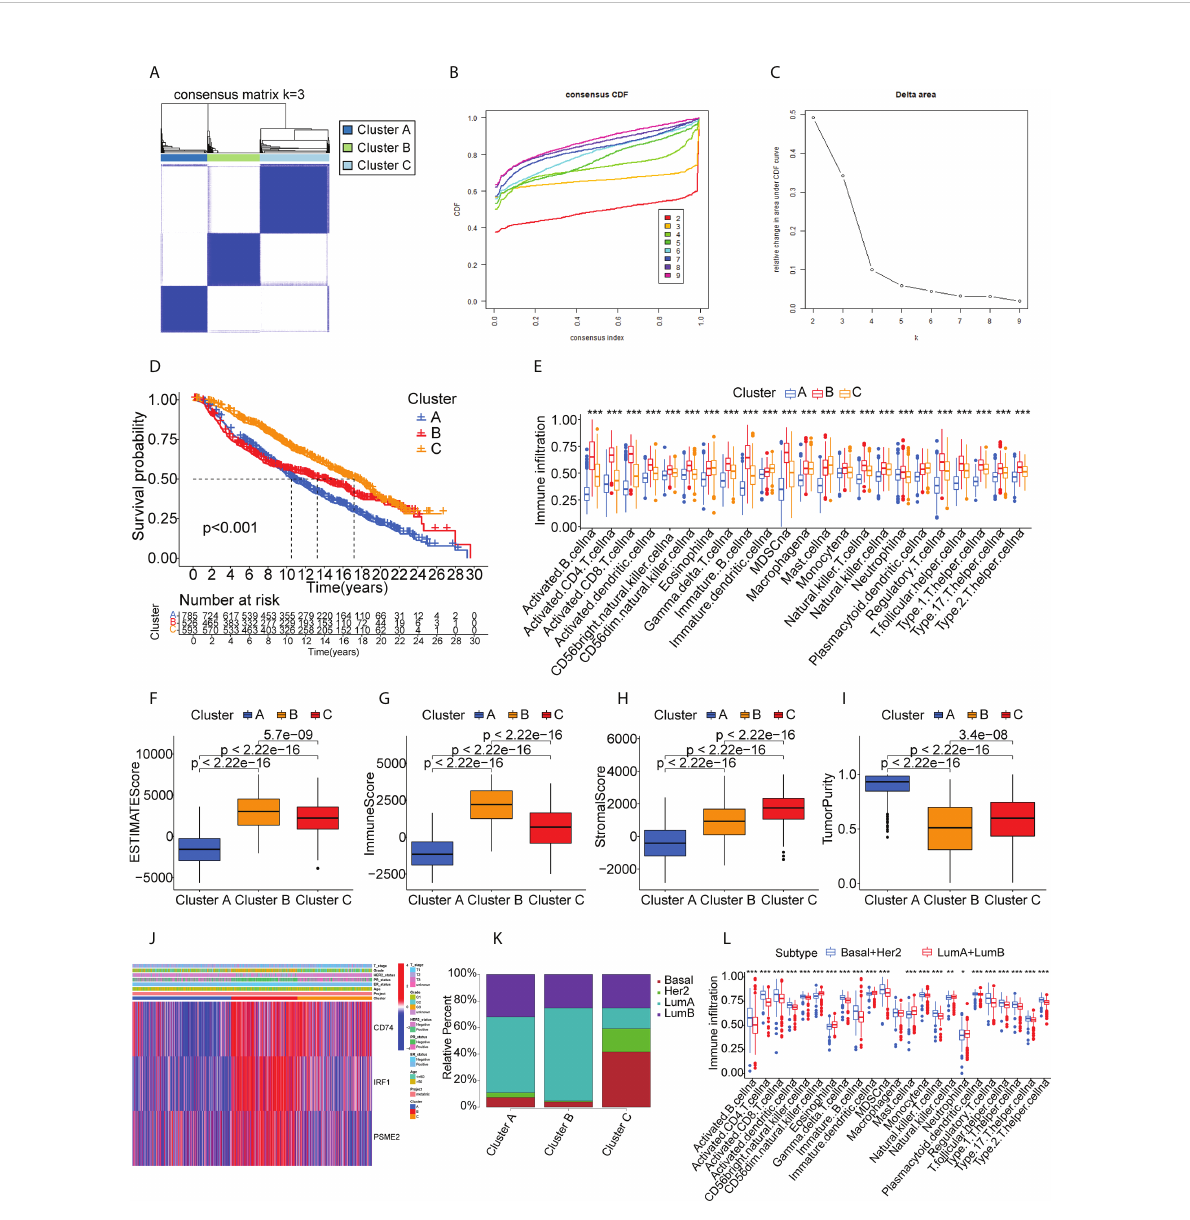
FIGURE 6 Cluster validation in the METABRIC cohort. (A-C) Cluster division based on levels of prognostic immune-related genes. (D) Survival analysis. (E) Boxplot showing immune cell in fi ltration, shown by ssGSEA enrichment. (F-I) Immune-stromal scores and tumor purity in the clusters, shown by ESTIMATE. (J) Heatmap of tumor antigen expression and clinical parameters. (K) Distribution of immune clusters in patients with different subtypes. (L) Boxplot of immune cell in fi ltration levels, determined by ssGSEA. "*" represents that p-value <0.05; "**" represents that p- value <0.01, and "***" represents that p-value